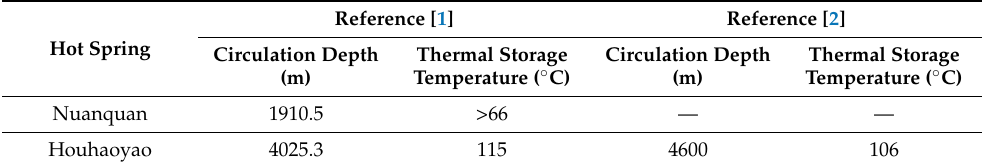
Table 2. The groundwater circulation depth and the thermal storage